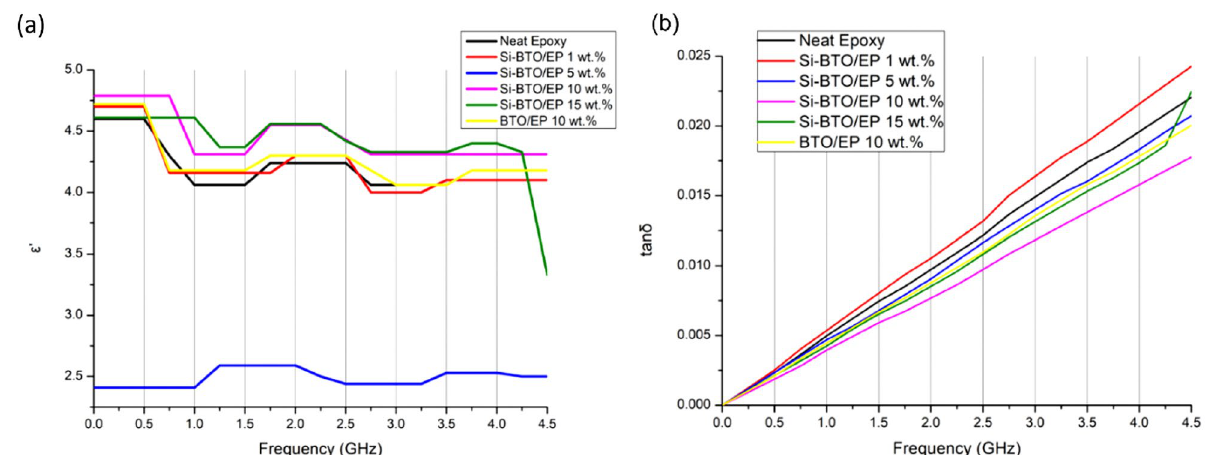
′ , ( b ) loss tangent tan ( δ ) from 0 to 4.5 GHz at room